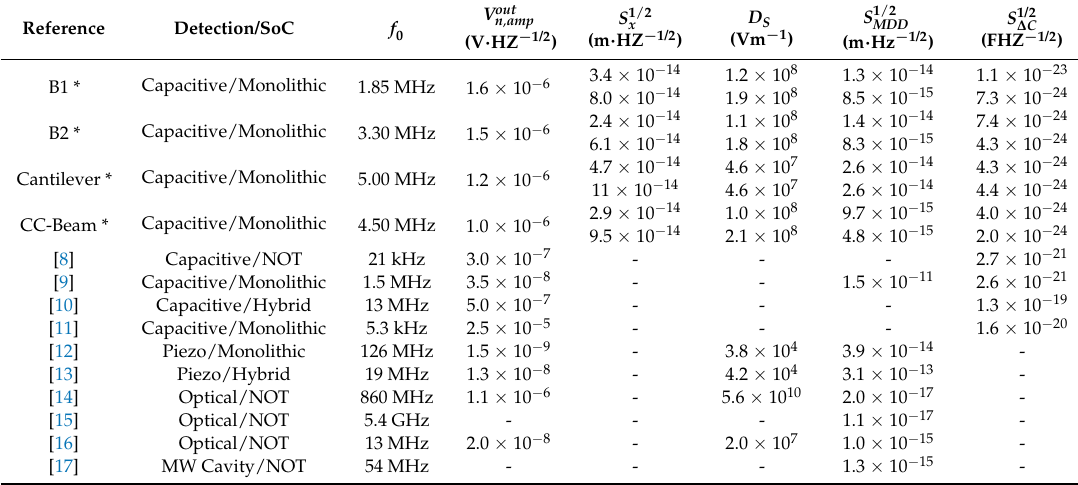
Table 4. State-of-the-art of MEMS resonator sensors including various fabrication approaches and readout systems. The results provided by this work * are obtained using the largest bias voltage in each case. The second row of the devices related to this work refers to the results obtained in vacuum, where the Q increase improves the displacement